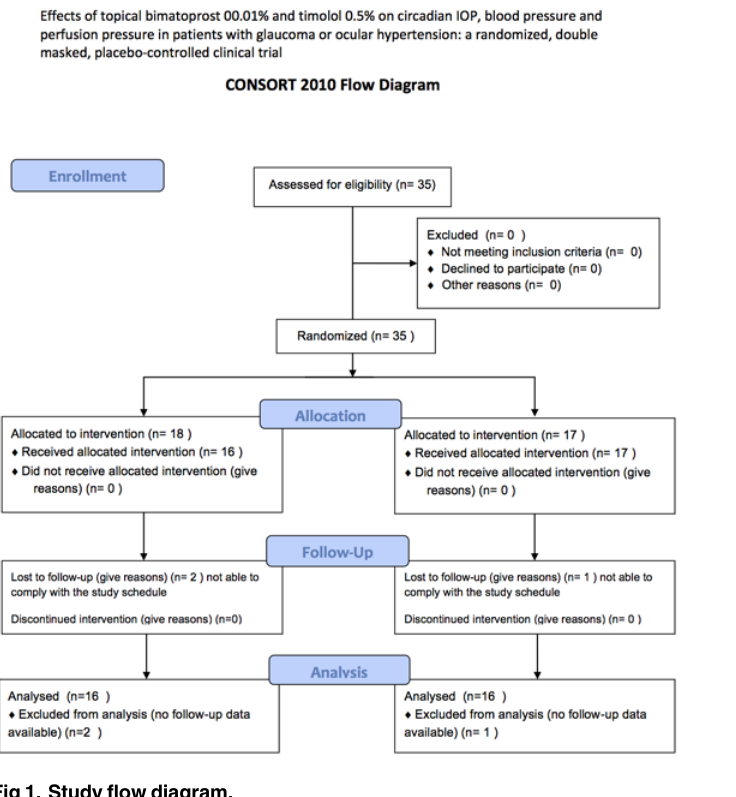
Fig 1. Study flow